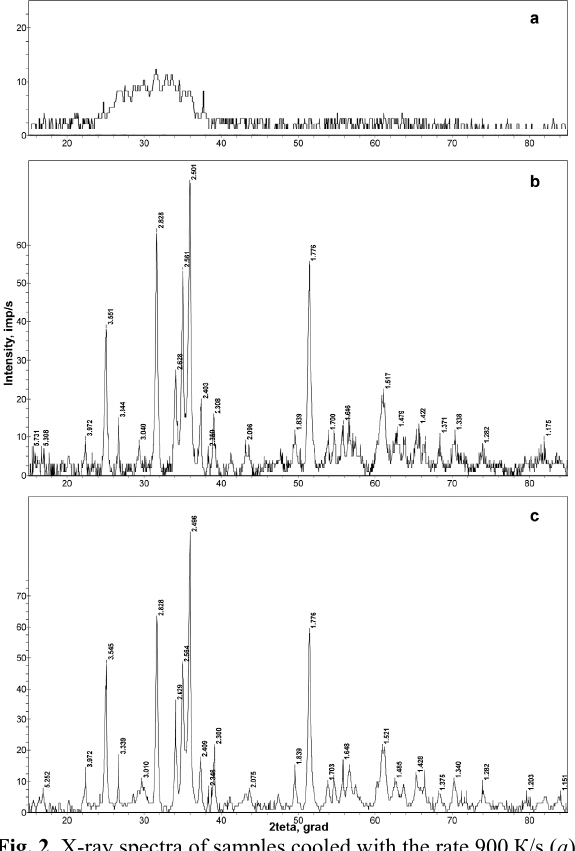
Fig. 2 . X-ray spectra of samples cooled with the rate 900 К /s ( а ) and annealed at 1023 К within 5 (b) and 60 min (c)